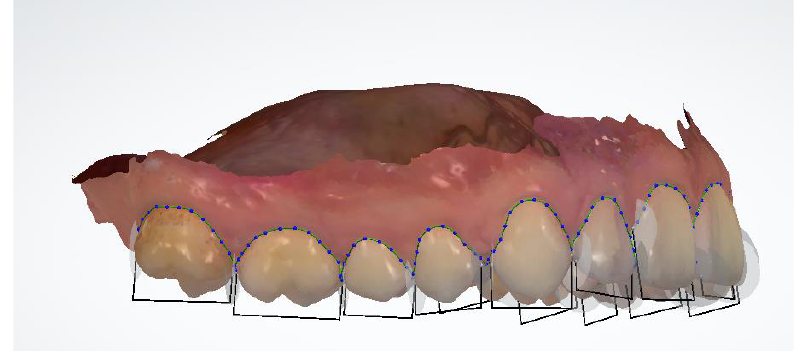
Figure 2. OrthoAnalyzer.